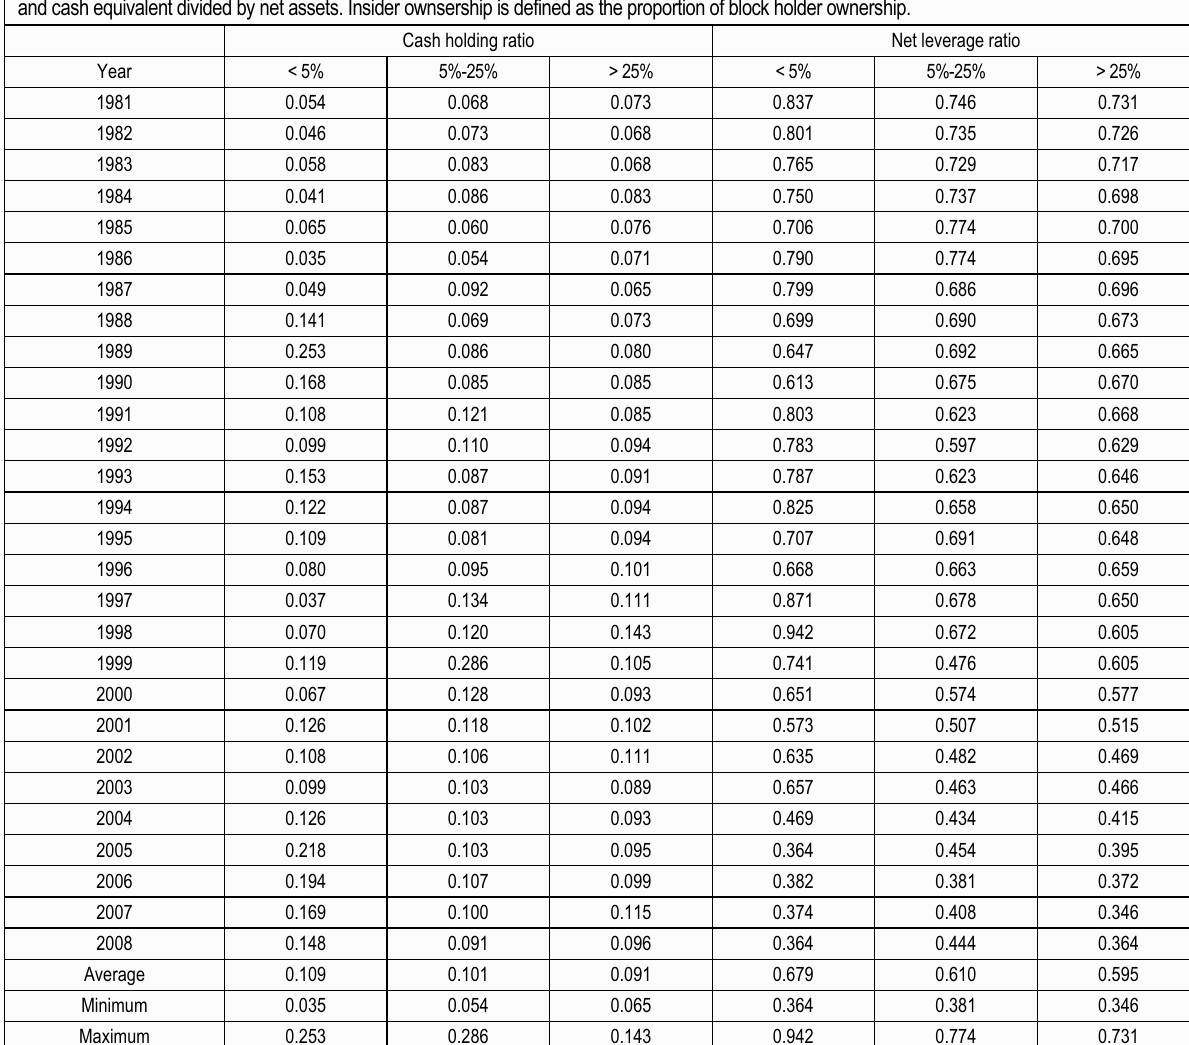
Table 2. Cash holding and net leverage ratios by insider